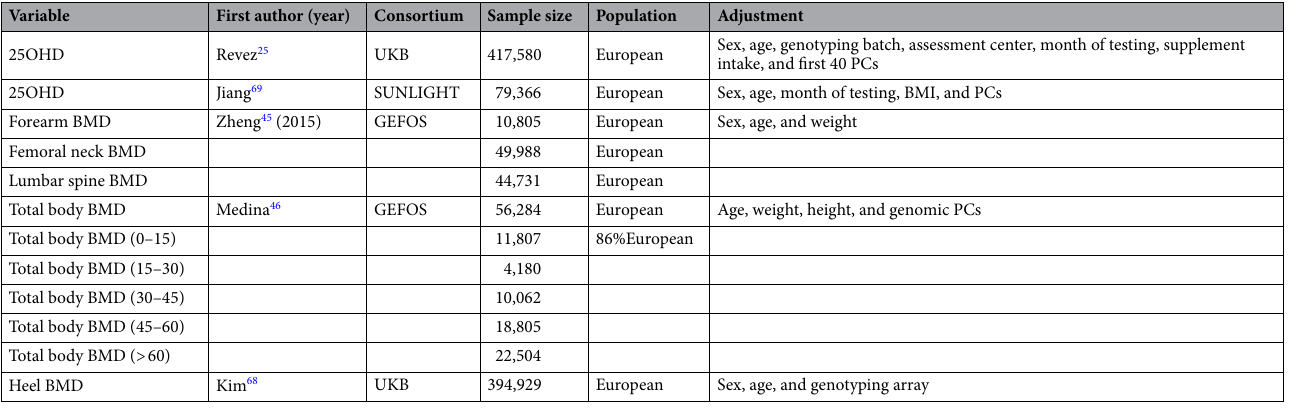
Table 2. Description of GWAS consortiums used for each phenotype. 25OHD 25-hydroxyvitamin D, BMD bone mineral density, UKB UK Biobank, SUNLIGHT Study of Underlying Genetic Determinants of Vitamin D and Highly Related Traits, GEFOS Genetic Factors for Osteoporosis, PC principal components, BMI body mass index. There is no sample overlap between 25OHD (Revez) and Forearm/Femoral neck/Lumbar spine/ Total body BMD. There is no sample overlap between 25OHD (Jiang) and Heel